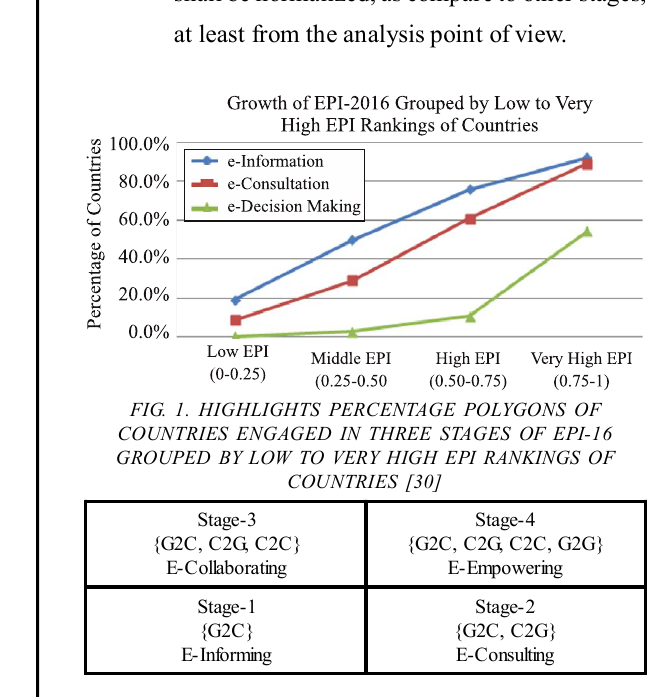
FIG. 2. SUPERIMPOSITION OF E-PartM MODEL ON A 4- STAGED GROUP OF INTERACTIONS OF STAKEHOLDERS AS A 4-QUADRANT MATRIX